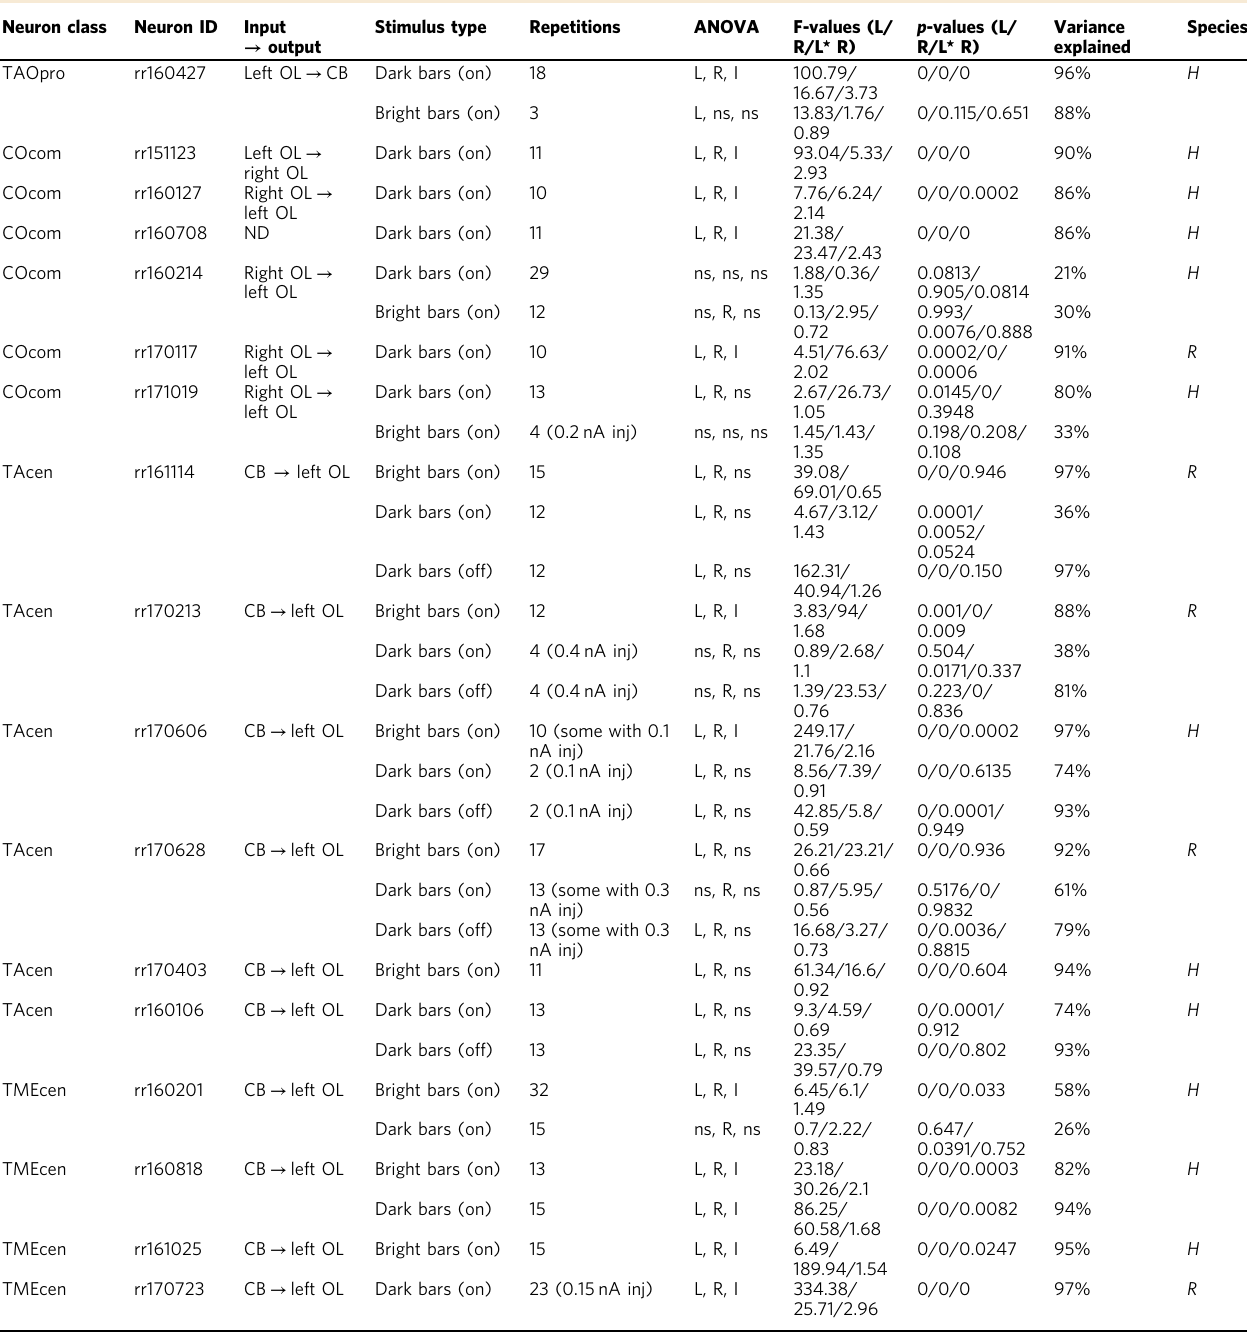
Sixth column indicates whether there was a signi fi cant ( p <0.05) main effect of left (L) or/and right (R) eye stimulation on neuronal response as tested with two-way-ANOVA (see Methods: Statistical analysis). A signi fi cant interaction term in the two-way-ANOVA is indicated by “ I ” , non-signi fi cance by ‘ ns ’ . Degrees of freedom were 6 for left and right eye main effects, respectively and 36 for interaction terms. F — and p -values are provided in 7th and 8th column, respectively. p -values smaller than 0.0001 are given as 0. Recordings were usually done without concurrent depolarizing current injectionunless indicatedby ‘ inj ’ withthe amount of current indicatedin nA. On-responses were evaluated ina 250ms time windowstarting 1msafter stimulusonset. Off responses were evaluatedin a 200mstimewindowstarting50msafterstimulusoff.Abbreviations: H , Hierodulamembranacea ;Llefteye,Iinteraction(L*R),NDnotdeterminable(noclearpeakresponse),nsnotsigni fi cant( p >0.05), OL optic lobe, CB central brain, R right eye, R , Rhombodera